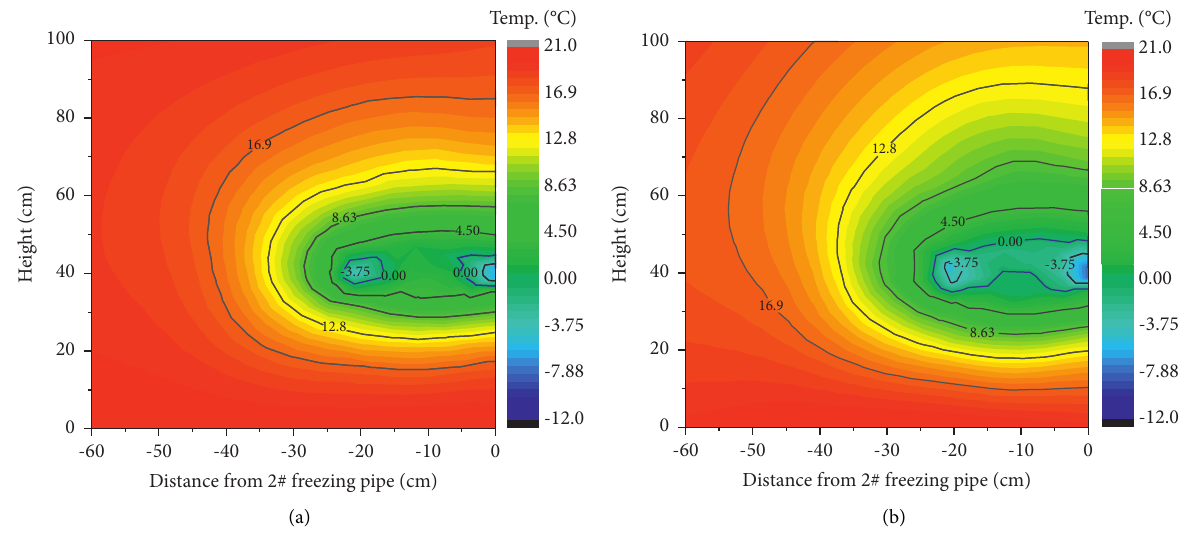
Figure 11: Temperature fields of gravel formation at a seepage flow rate of 5.0 m/d. (a) Freezing duration of 8 h. (b) Closure time of frozen wall 29.3 h.